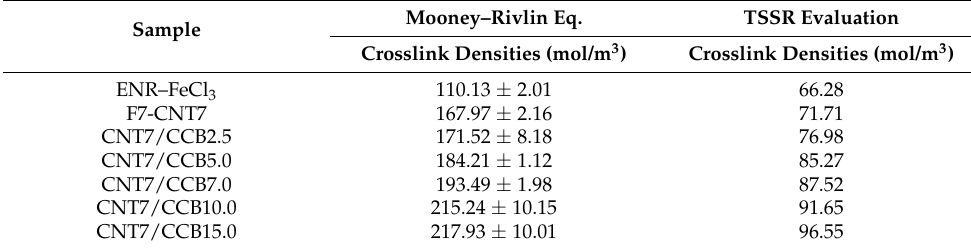
Table 5. Crosslink densities of ENR–FeCl 3 and its filled composites with CNTs (F7-CNT7) and CNT–CCB hybrid fillers with various loadings of